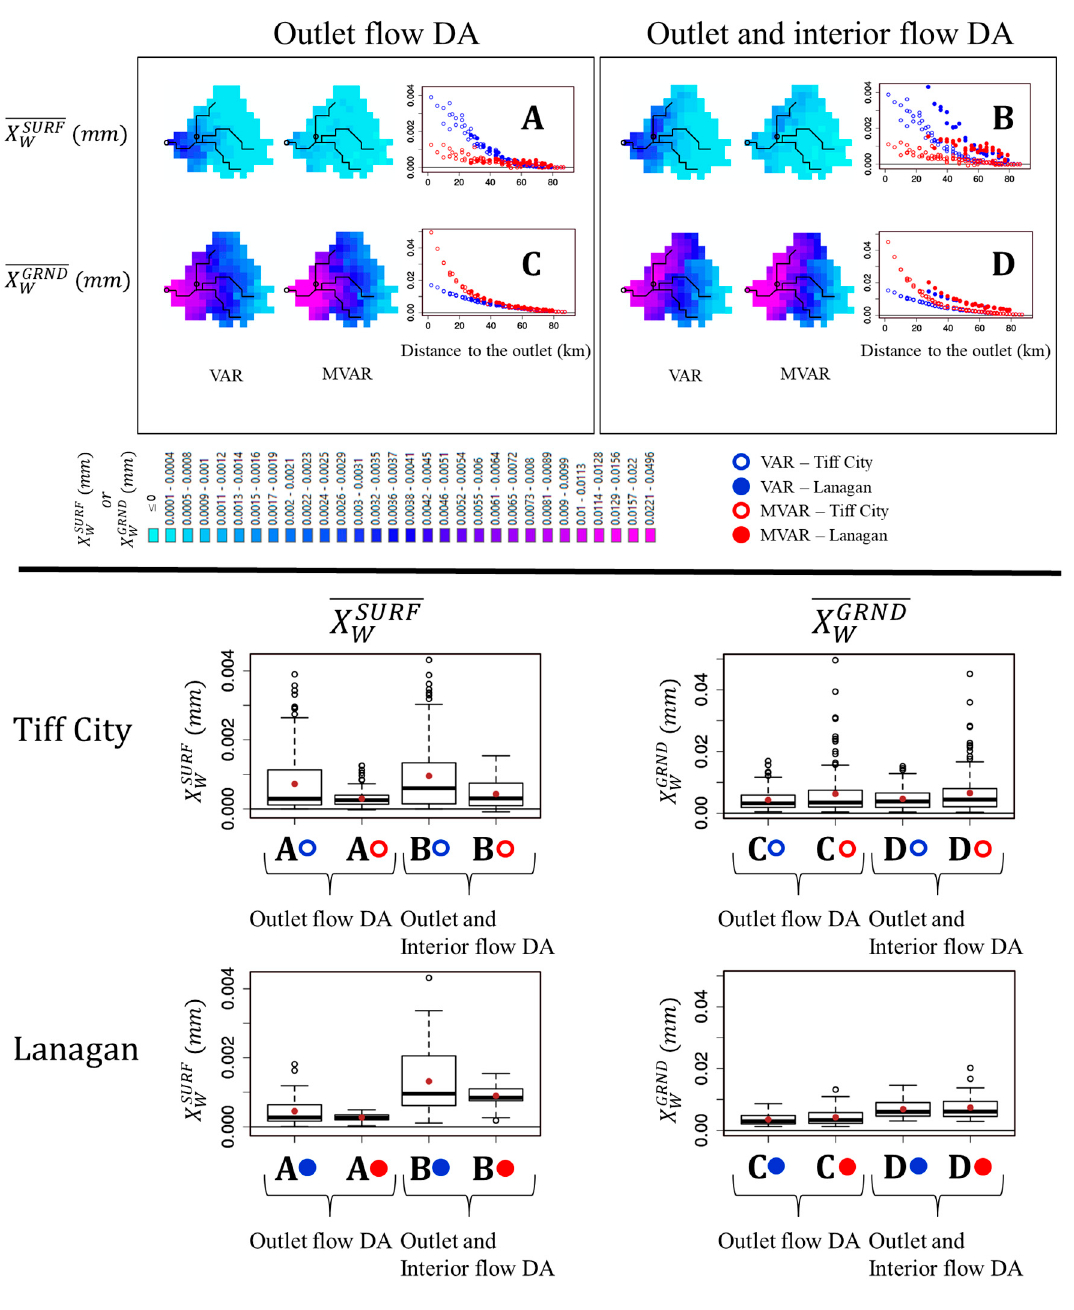
Figure 8. (cid:1850) (cid:3024)(cid:3020)(cid:3022)(cid:3019)(cid:3007) (cid:3364)(cid:3364)(cid:3364)(cid:3364)(cid:3364)(cid:3364)(cid:3364)(cid:3364) and (cid:1850) (cid:3024)(cid:3008)(cid:3019)(cid:3015)(cid:3005) (cid:3364)(cid:3364)(cid:3364)(cid:3364)(cid:3364)(cid:3364)(cid:3364)(cid:3364) (Equation (22)) from MVAR and VAR.